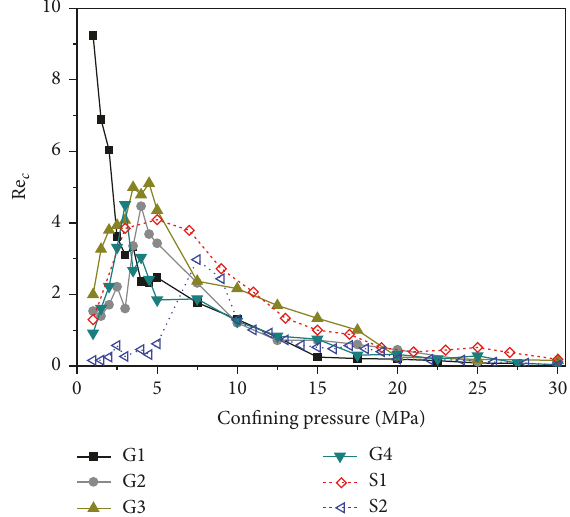
Figure 12: Relationships between Re 𝑐 and 𝜎 𝑛 based on the data replotted from Zhou et al. ([94], Figure 8 ).